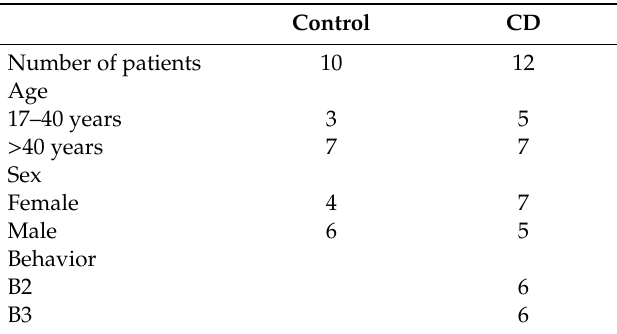
Table 1. Patients